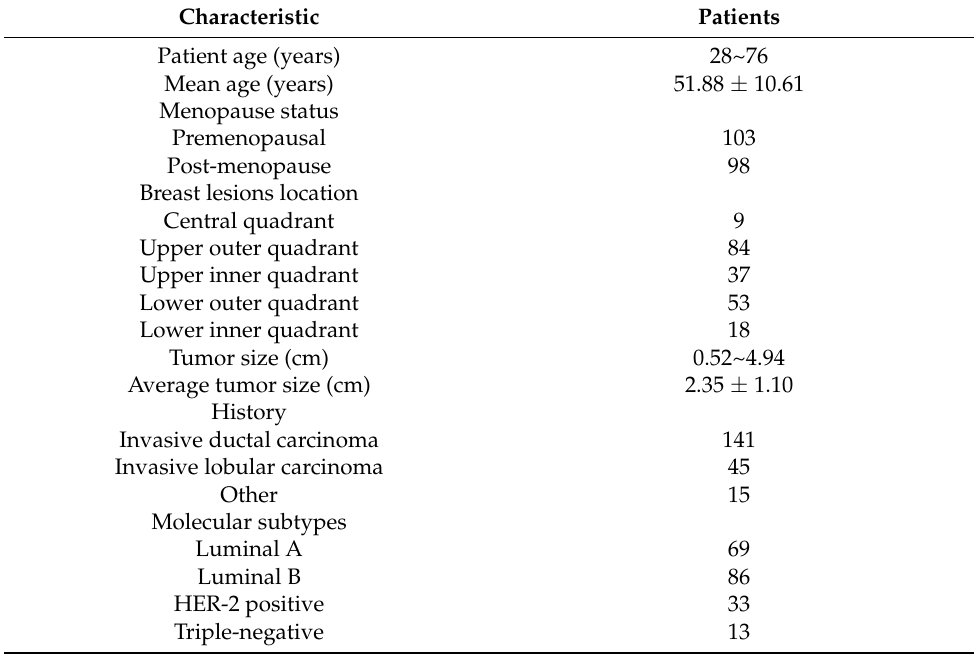
Table 1. Demographic characteristics of the included patients ( n =